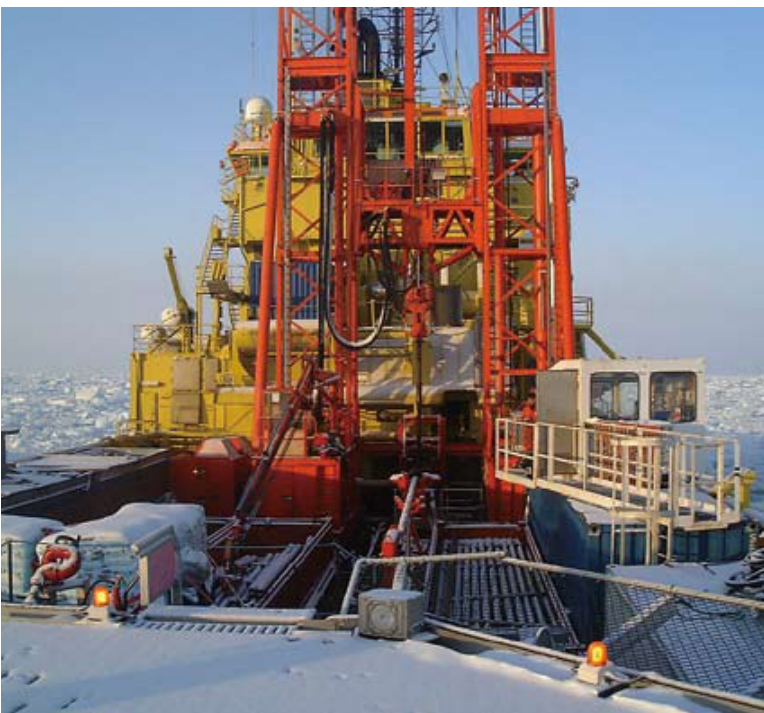
Figure 1. Drilling on a sunny day in the Arctic.